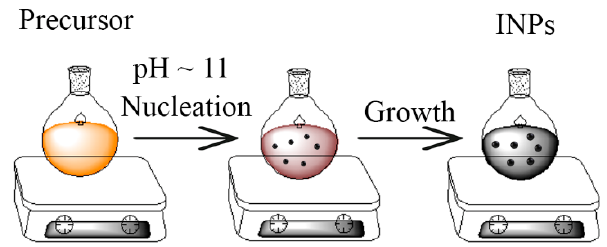
Scheme 1. Schematic illustration of a common precipitation reaction, INPs stands for iron nanoparticles.